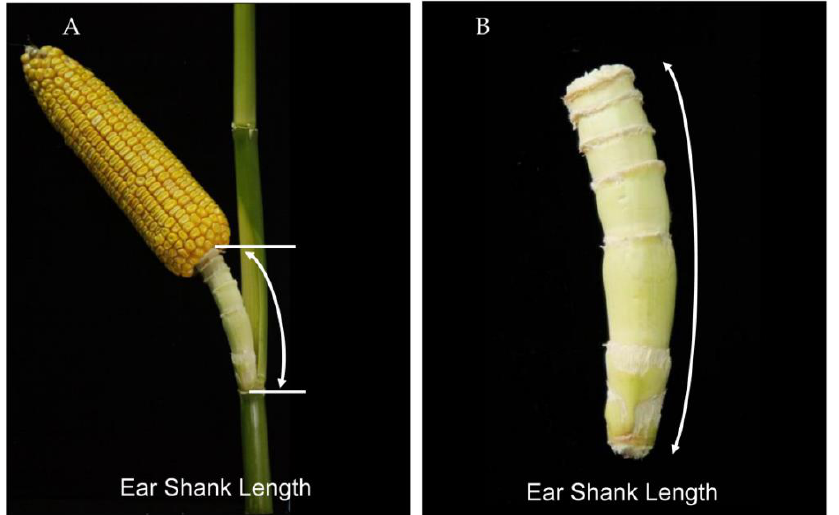
Figure 6. Schematic diagram of measurement of ear shank length. ( A ) Maize ear and its shank. ( B ) ear shank length examined in the present study. The white curves with arrows indicate the ear shank